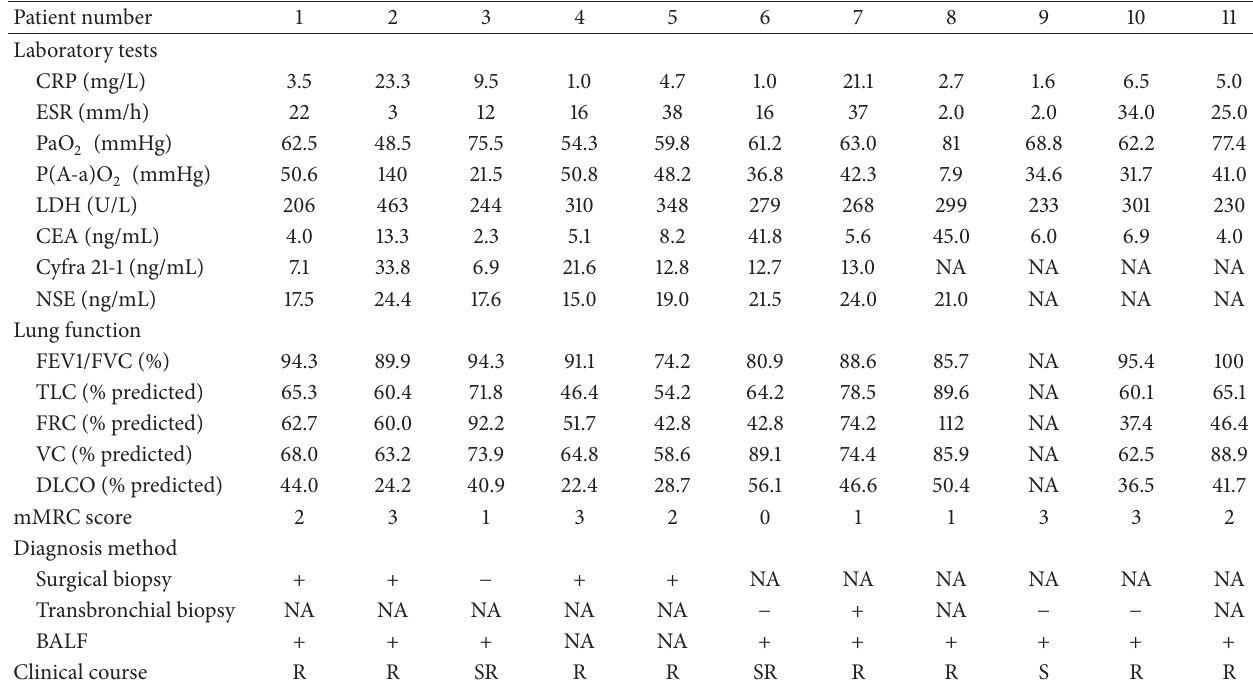
Table 2: Clinical examinations of PAP patients.